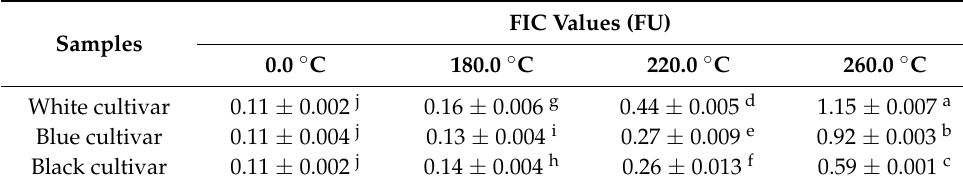
Figure 3. Fluorescence spectrum of the FIC in the raw and CHB roasted at different temperatures. Table 4. FIC values in the raw and CHB roasted at different temperatures.